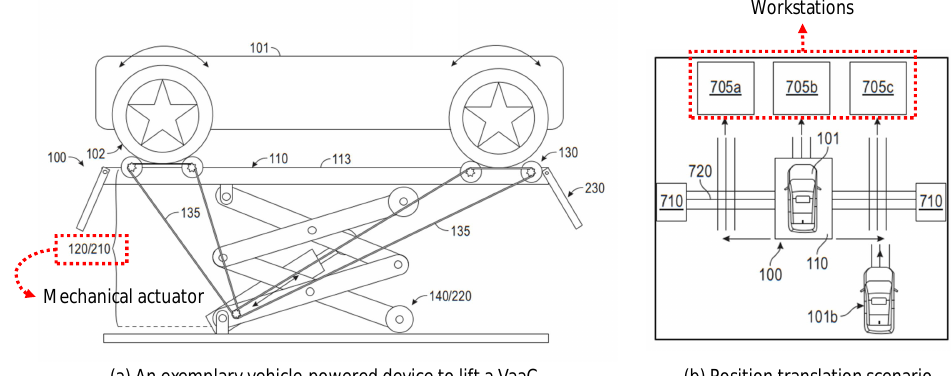
Figure 5. VaaC-powered Figure 5. VaaC powered devices.